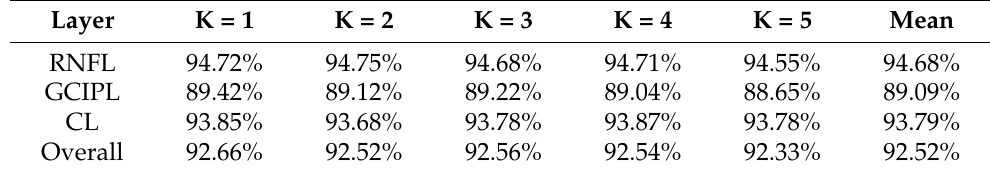
Table 6. Test results of DSC with five-fold